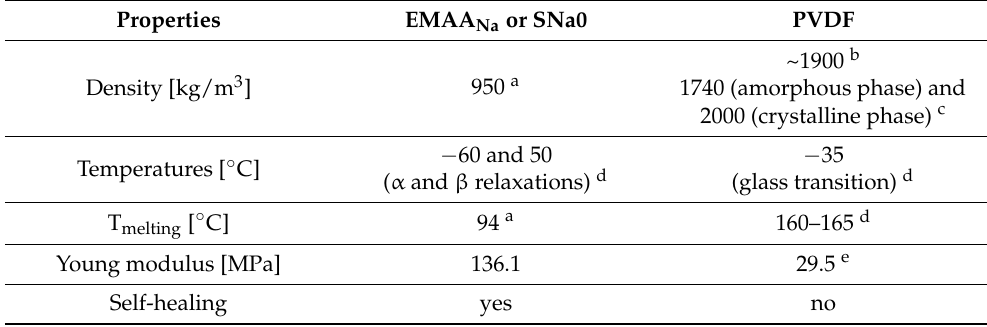
Table 5. Comparison of properties and characteristics: ionomer EMAA Na versus